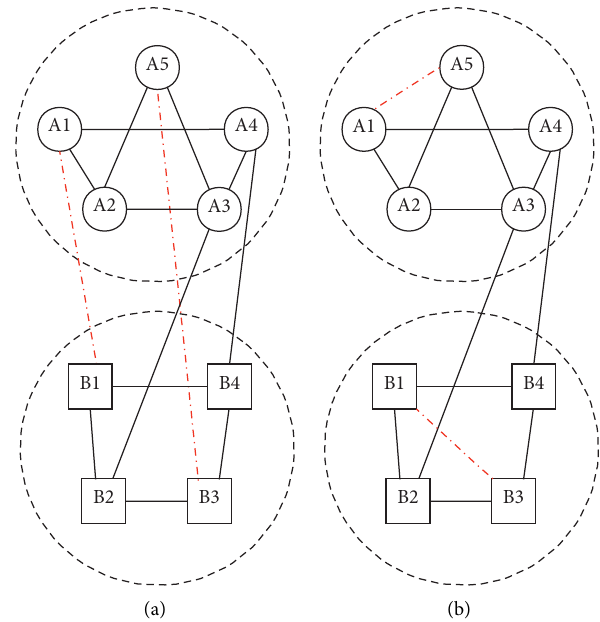
Figure 2: The operation of edge rewiring for strengthening community structures.